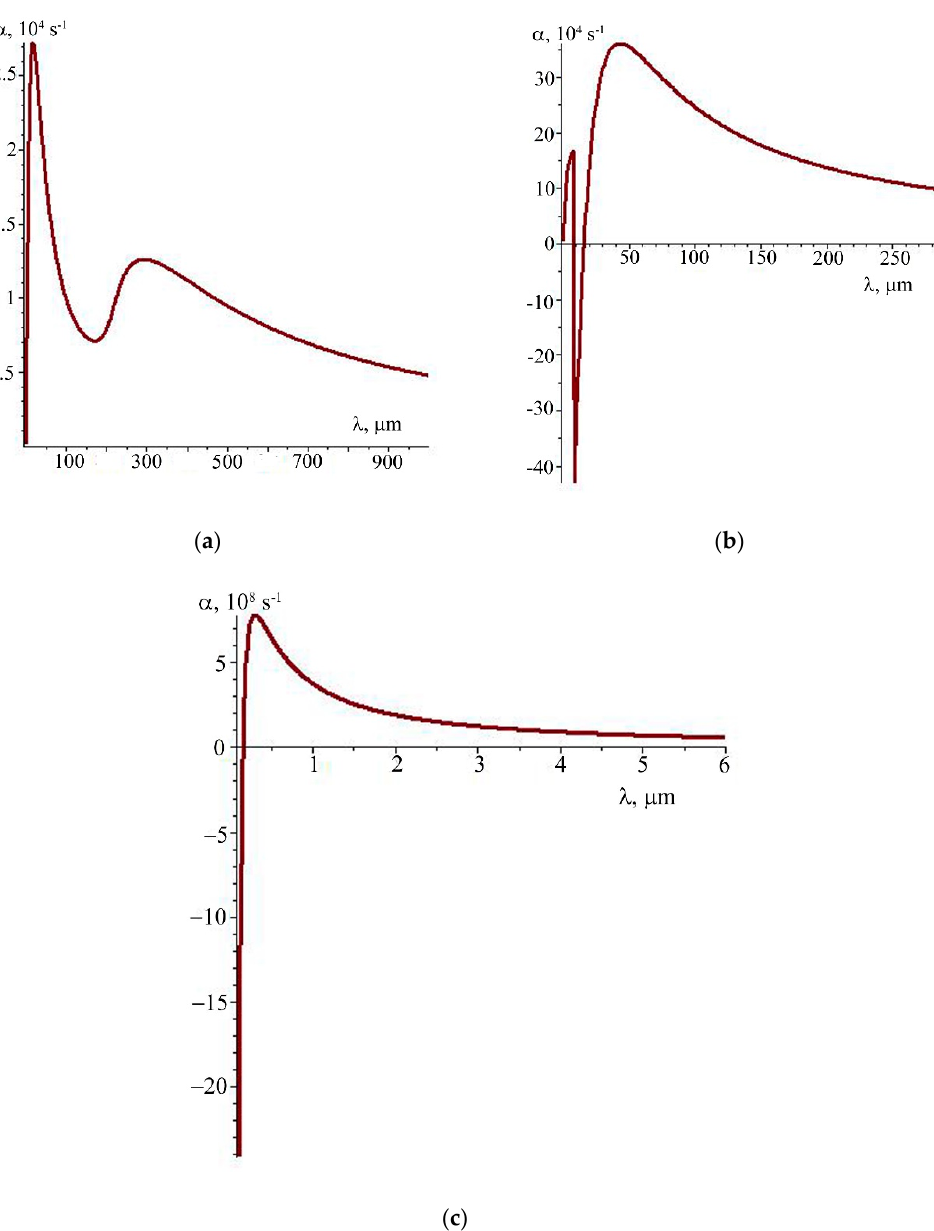
Figure 8. A growth rate characteristic of perturbations on the plasma–melt interface for the Ti-Y system found when solving the Equation (9): ( a ) ignoring thermoelectric and evaporation and capillary effects, ( b ) for thermoelectric field strength of 10 5 V/m, ( c ) for thermoelectric field strength of 10 6 V/m.